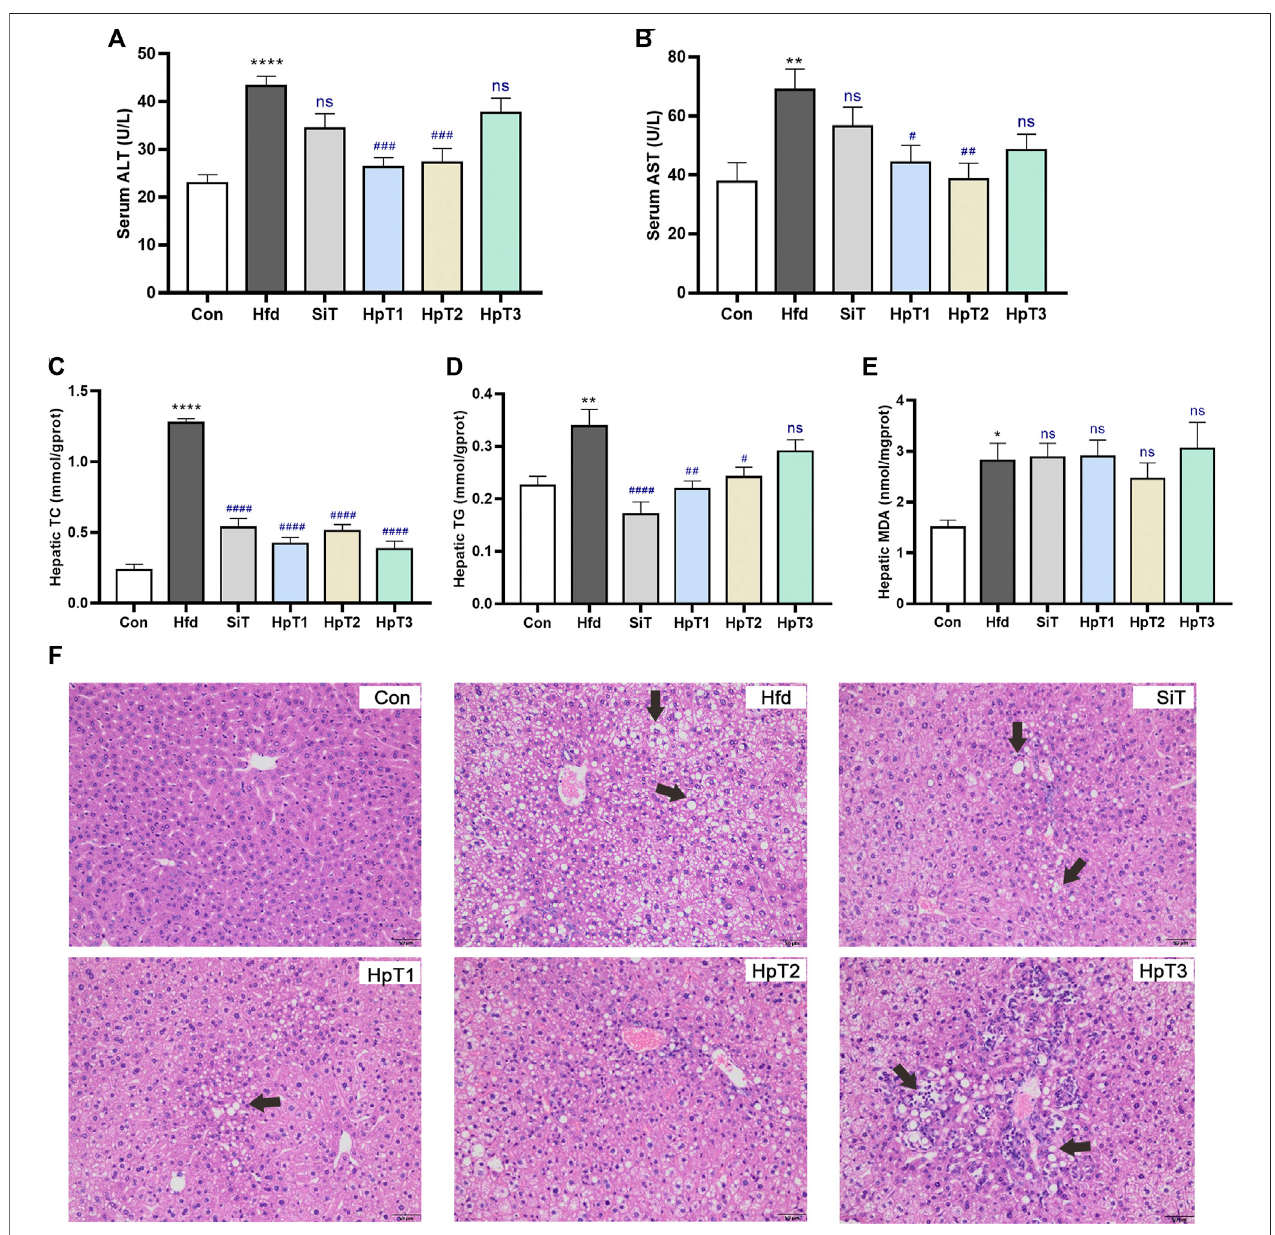
FIGURE 1 | Huangjiu peptide T1 and T2 treatment alleviated aberrant lipid metabolism in the liver induced by high-fat diet. Mice were fed with high-fat diet for 8 weeksexceptcontrol(Con)groupweretreatedwithnormaldiet;Miceofthehigh-fatdietgroup(Hfd)weretreatedwithsalineandfedwithhigh-fatdietfor8 weeks;the simvastatin treatmentgroup (SiT) were treatedwith simvastatin (6 mg kg − 1 );and huangjiupeptide T1group (HpT1), huangjiupeptide T2 group(HpT2), huangjiupeptide T3 group (HpT3) were administrated with huangjiu peptide T1, T2 or T3 (0.3 g kg − 1 ) by gavage, respectively. These group names were used throughout this researchpaper.Levels of (A) ALT and (B) ASTin serum weredeterminedbybiochemical kits, and these samples wereobtained from Con, Hfd,SiT, HpT1, HpT2, HpT3 micegroups.Levelsof (C) TC, (D) TGand (E) MDAinliverweremeasuredthoughtkitsandcalculatedaccordingtohepaticproteincontent. (F) Representativelivertissue sections were stained with H&E to indicate lipid contents and bars (cid:2) 50 μ m. Data were presented as mean ± SEM of six to nine mice per group. Unpaired two-tailed t tests were used between Con and Hfd groups, and the black * was labelled on column with * p < 0.05, ** p < 0.01, **** p < 0.0001. One-way ANOVA analyses were applied followed by Dunnett ’ s multiple comparisons test, and the signi fi cant p value of each group was compared with Hfd group. The blue # label indicated # p < 0.05, ## p < 0.01, ### p < 0.001, #### p < 0.0001, and ns means no signi fi cant differences.